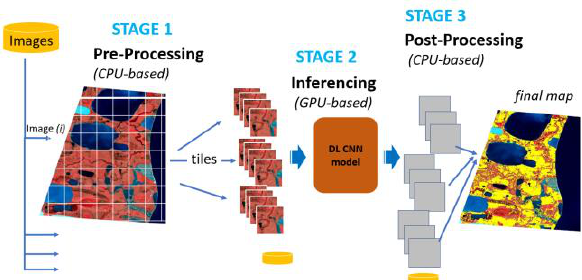
Figure 1. Simplified schematic of the Mapping Application for Permafrost Land Environment (MAPLE). Imagery © 2016 DigitalGlobe, Inc